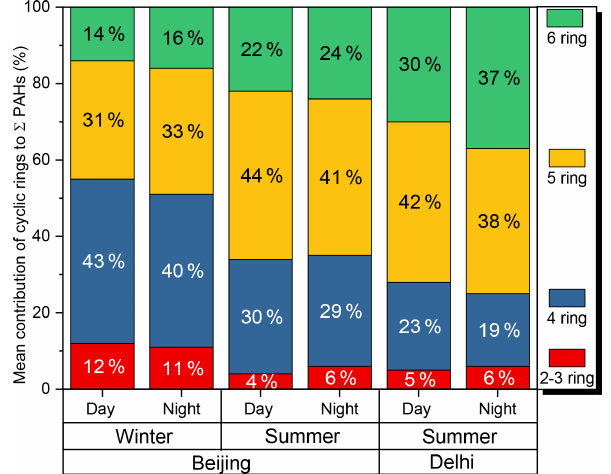
Figure 6. Distribution of PAH compounds by number of cyclic rings in PM 2 . 5 samples collected during the daytime (every 3h) and night-time (15h) for summer Beijing 2017 and Delhi 2018 (this study) and winter Beijing 2016 (Elzein et al.,